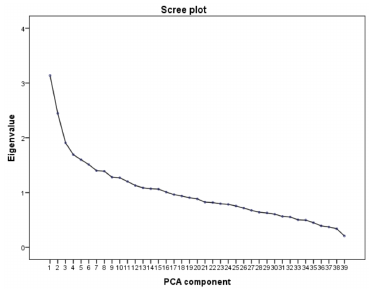
Figure 1. Scree plot of the eigenvalues. The scree plot, used to determinate the appropriate number of principal components, shows the eigenvalues, which represent the partitioning of the total variation accounted for by each principal component against the PCA component number.